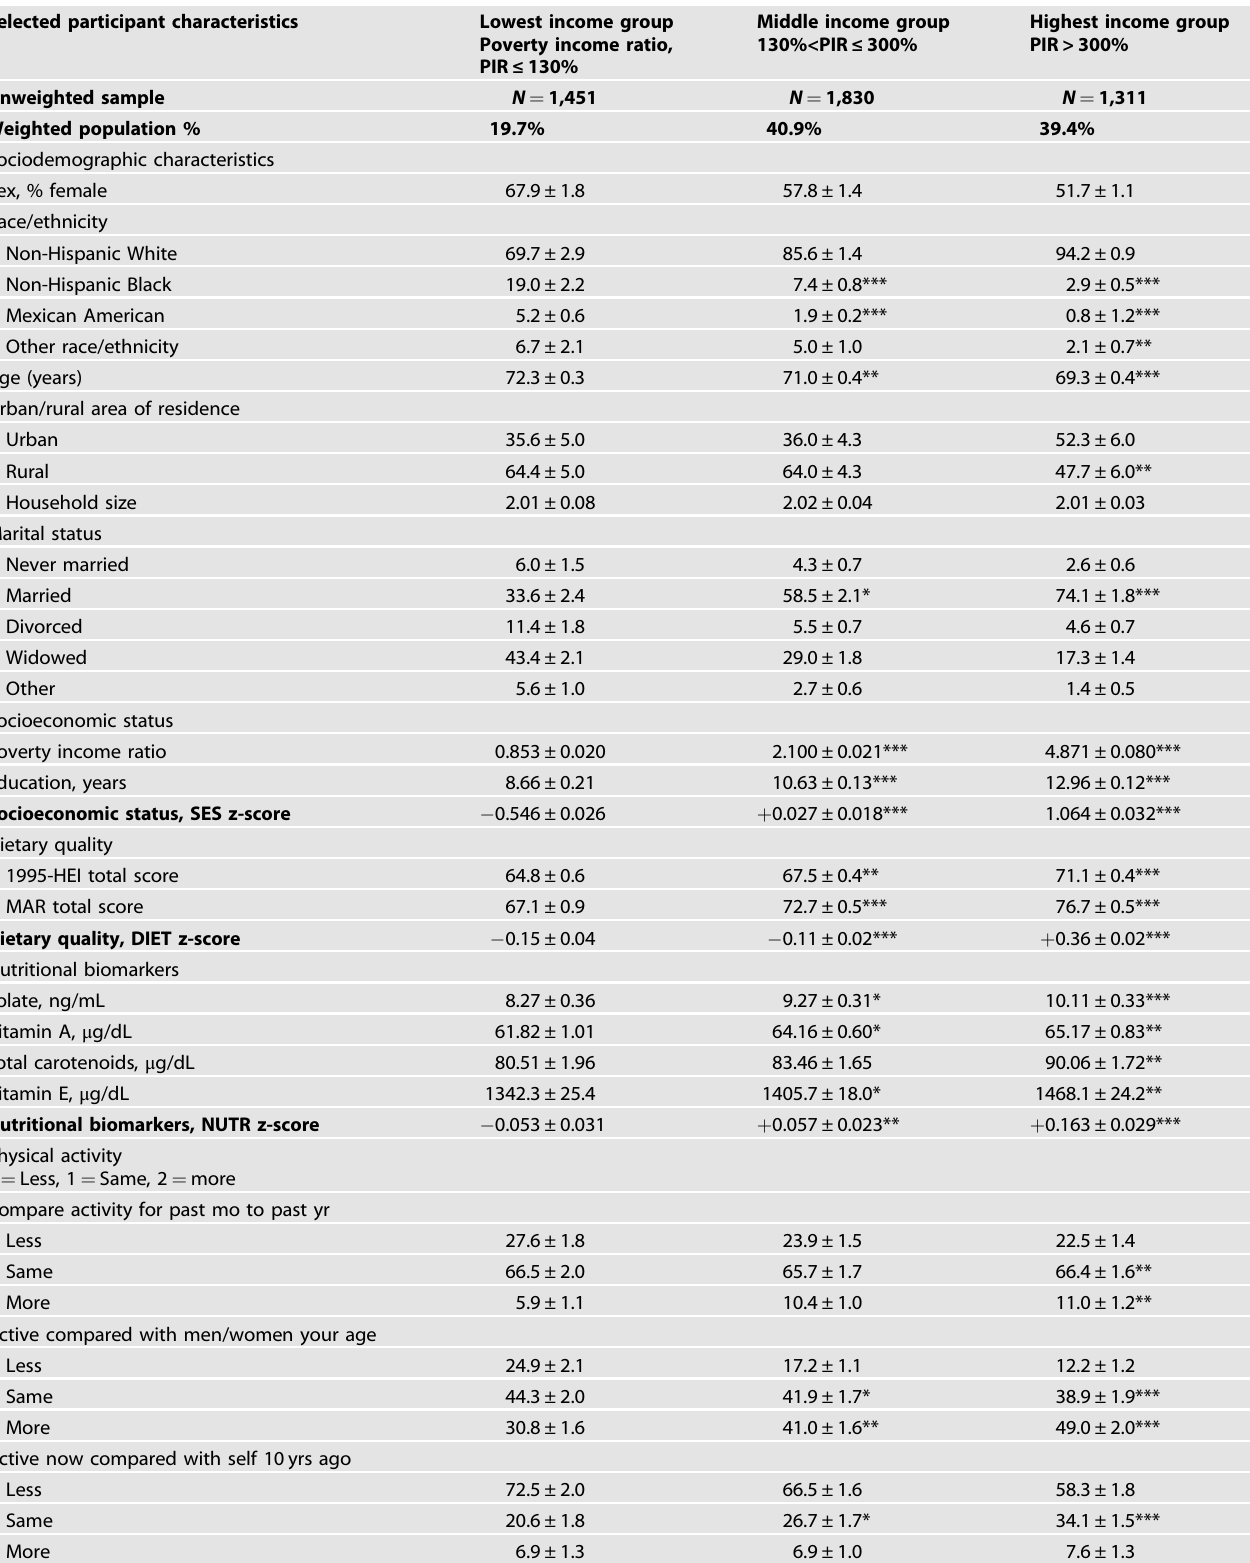
Table 1. Baseline characteristics of selected participants by race/ethnicity among older adults ( ≥ 60 y), across income groups NHANES III, 1988 – 1994 (Unweighted N = 4,592; Weighted N = 35,551,773) a